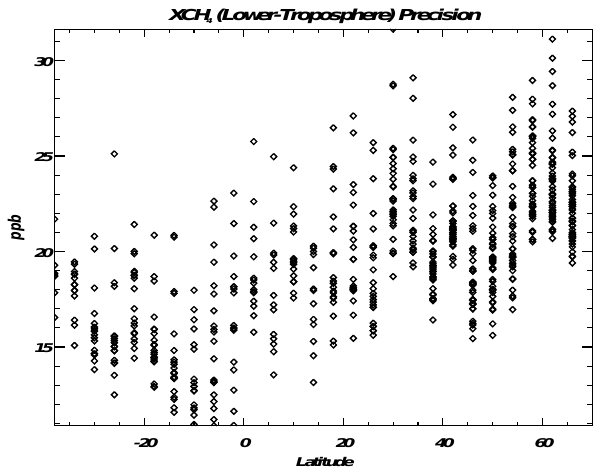
Figure 8. Estimated total precision for the GOSAT/TES lower tro- pospheric CH 4